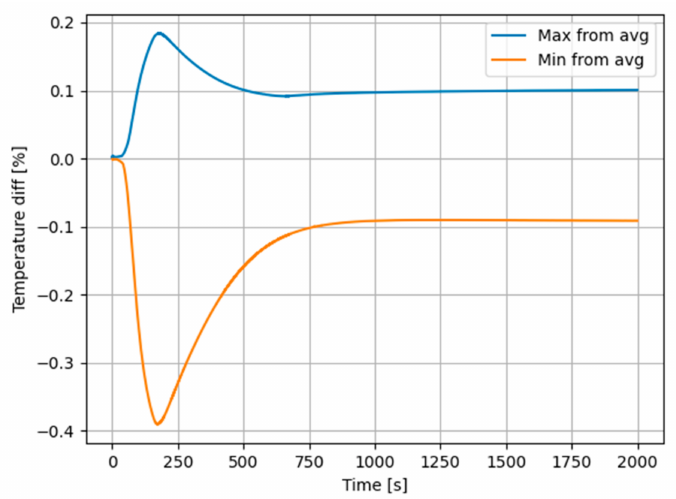
Figure 8. Time evolution of the maximum and minimum temperatures in the emitter ring for an input power of 300 W.